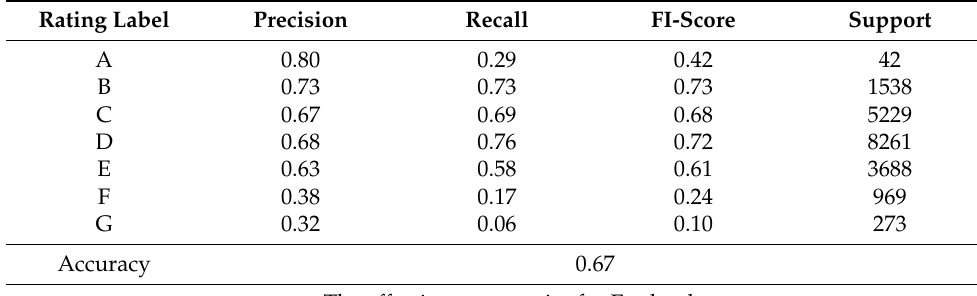
Table 12. Effectiveness metrics for the prediction algorithm across countries. Rating Label